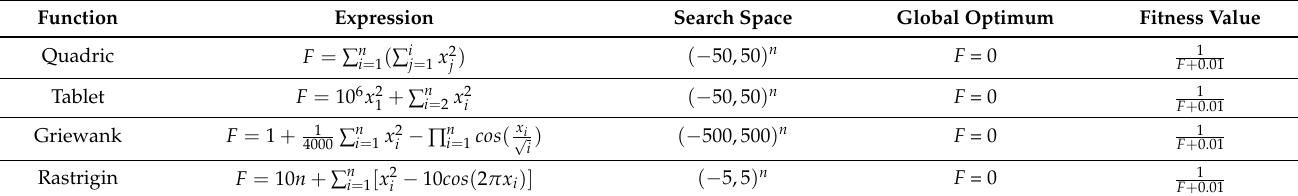
Table 1. Information of test